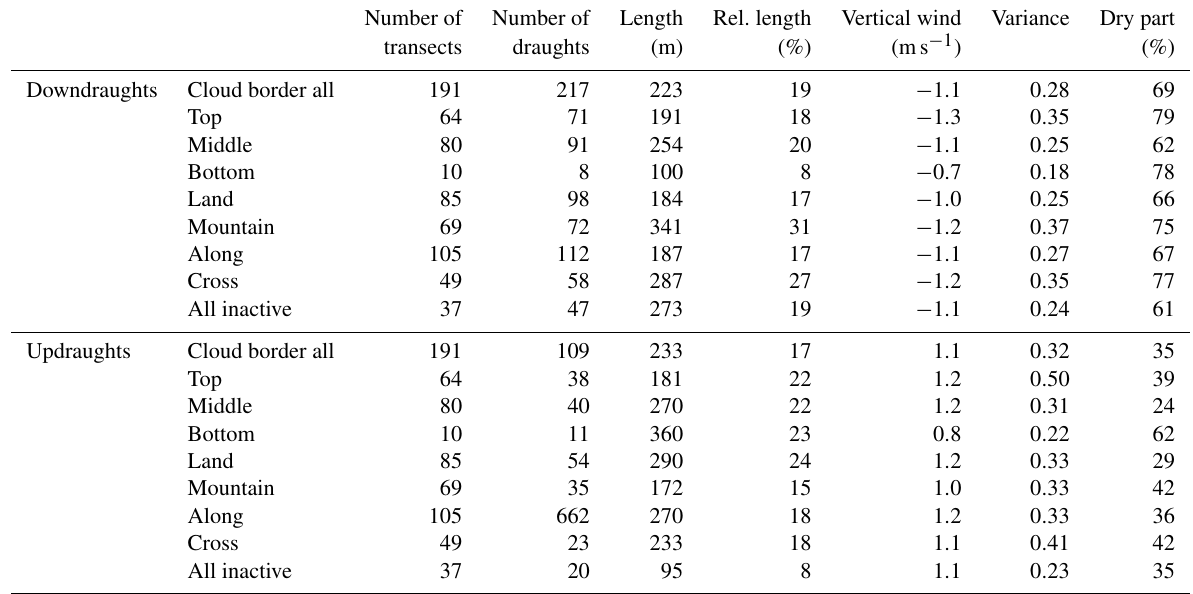
at the cloud border. The last two columns are missing; instead, the portion of the dry part as in Table 8 is